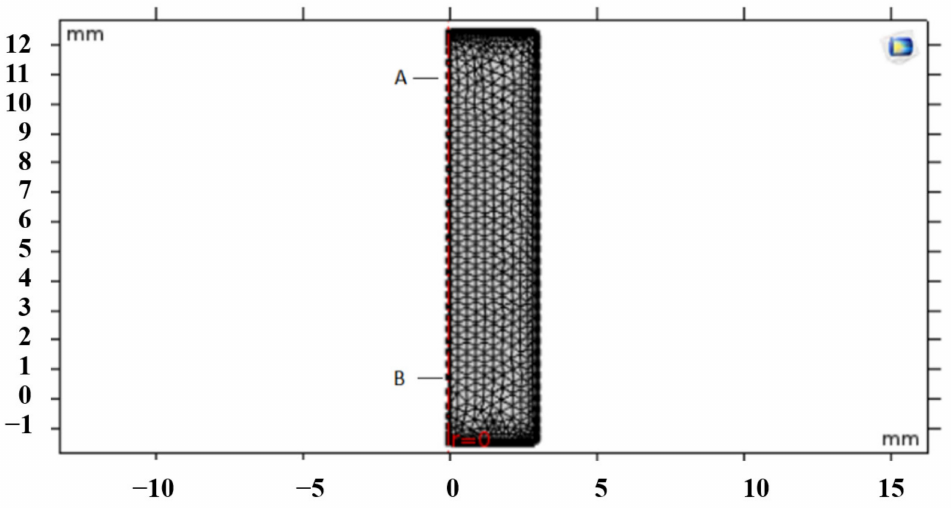
Figure 4. Arc-quenching unit structure.